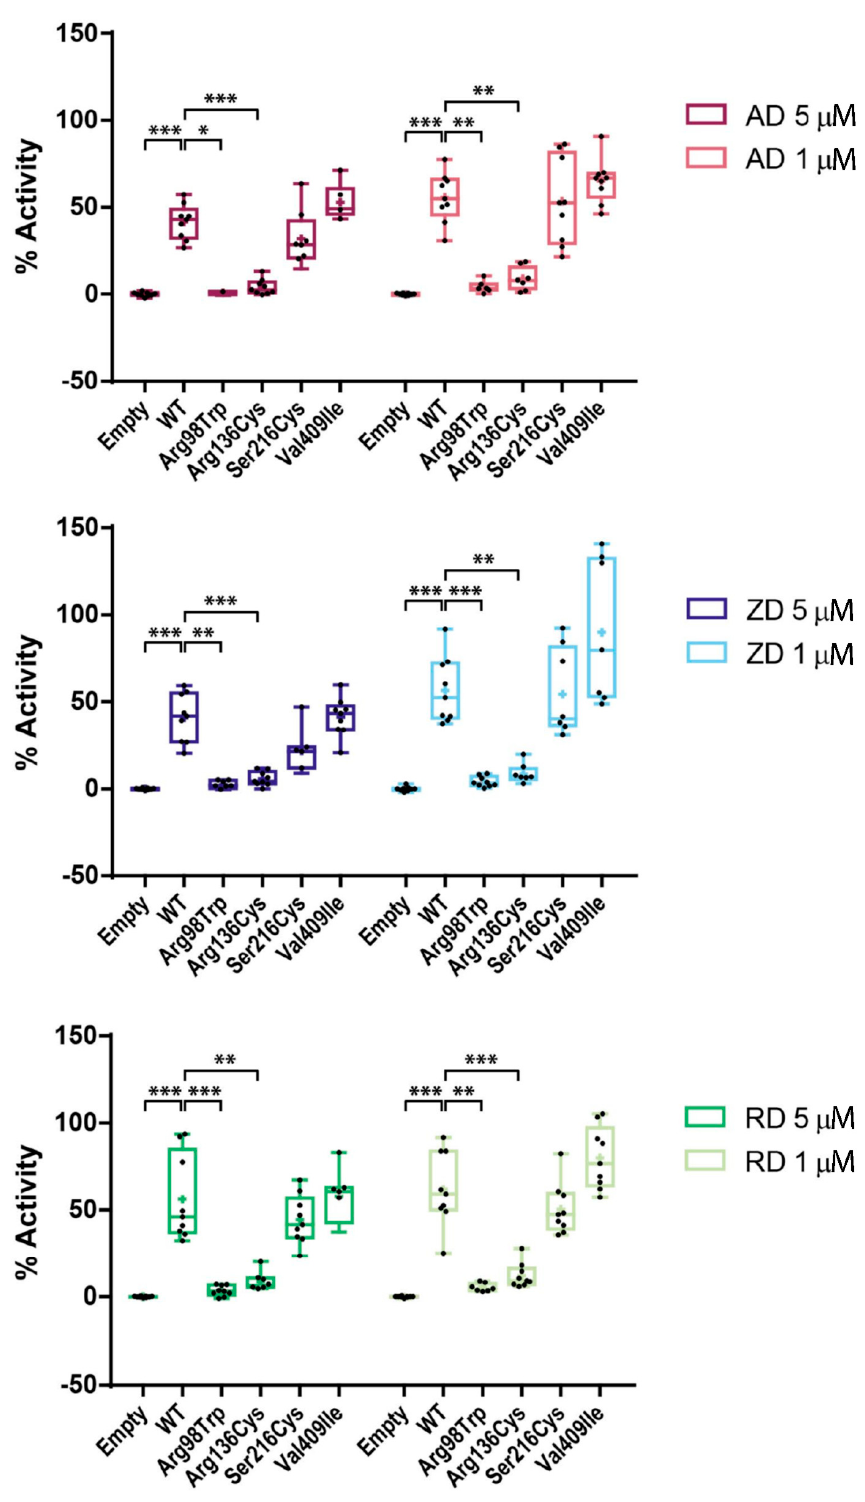
Figure 4. Effects of alendronate (AD), zoledronate (ZA), and risedronate (RD) at the indicated con- centrations on the enzymatic activity of wild-type CYP1A1 protein and CYP1A1 variants Arg98Trp, Arg136His, Ser216Cys, and Val409Ile (* p < 0.05; ** p < 0.01; *** p < 0.001). Activities are expressed as percentages of the untreated wild type. All experiments were performed thrice including three replicas each and p values < 0.05 were considered significant.